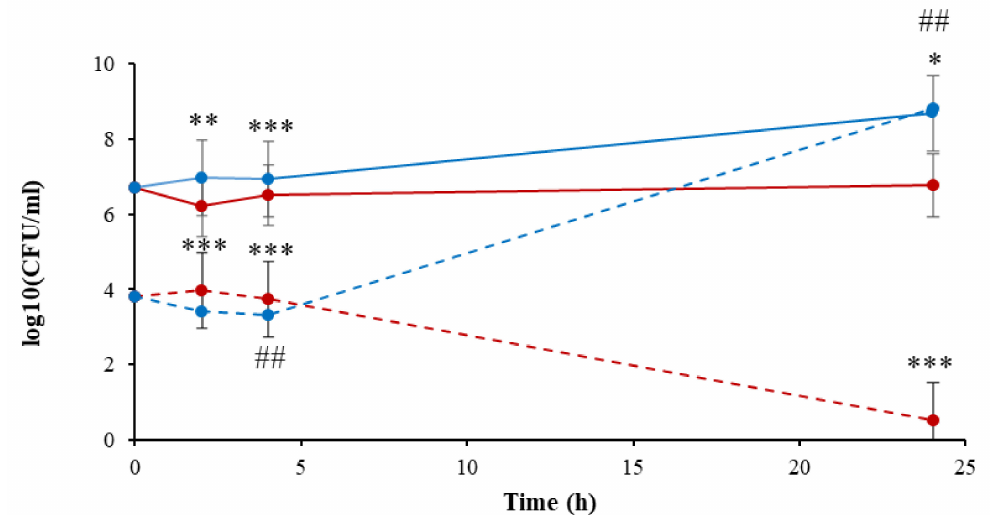
Figure 3. A. tumefaciens viability during 24 h, as a response to plasma treatment of 30 sec followed by suspension in PBS ( ) and LB ( ), compared to the controls of the nontreated bacteria in PBS ( ) and LB ( ). Results are the mean of SD of three independent experiments. P -value significance is presented by t -test of CFU/ml of the plasma-treated A. tumefaciens in LB, compared